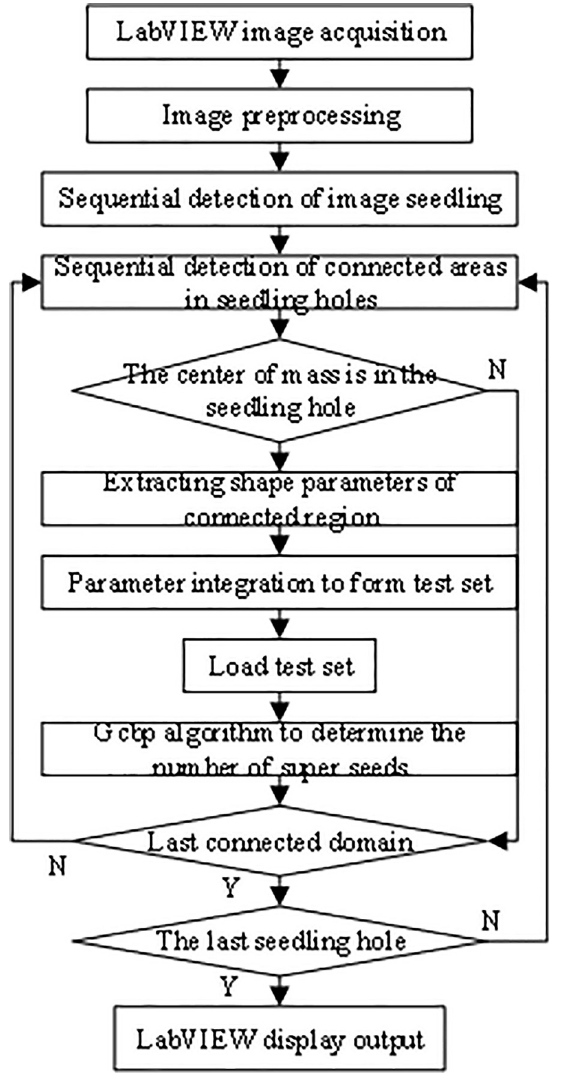
Fig 7. The overall process of visual inspection based on GABP